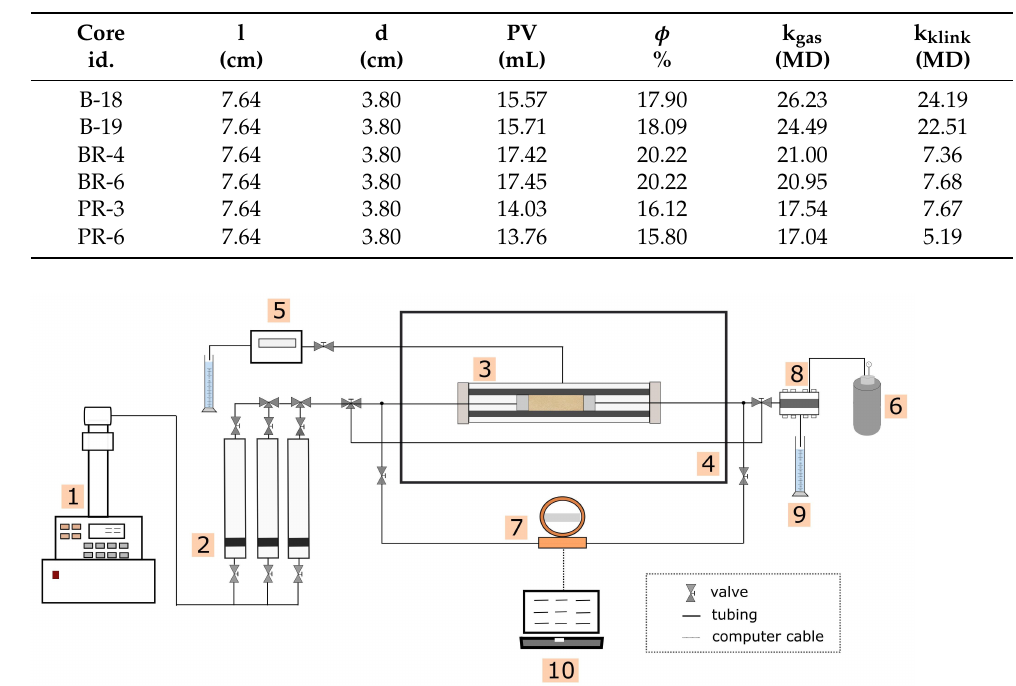
Table 2. Core data for the homogeneous (Berea) and heterogeneous (Bandera Brown and Parker) sandstone rocks used in the experiments.